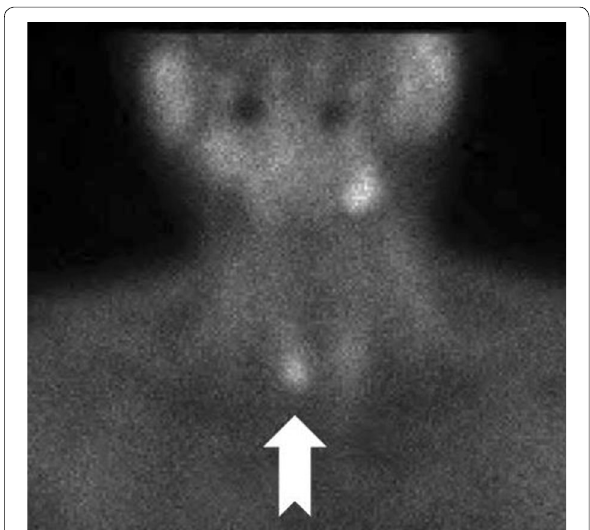
Fig. 3 MIBI scintigraphy The MIBI scintigraphy showed accumulation near the lower right pole and strong accumulation even in the delayed phase, suggestive of a parathyroid